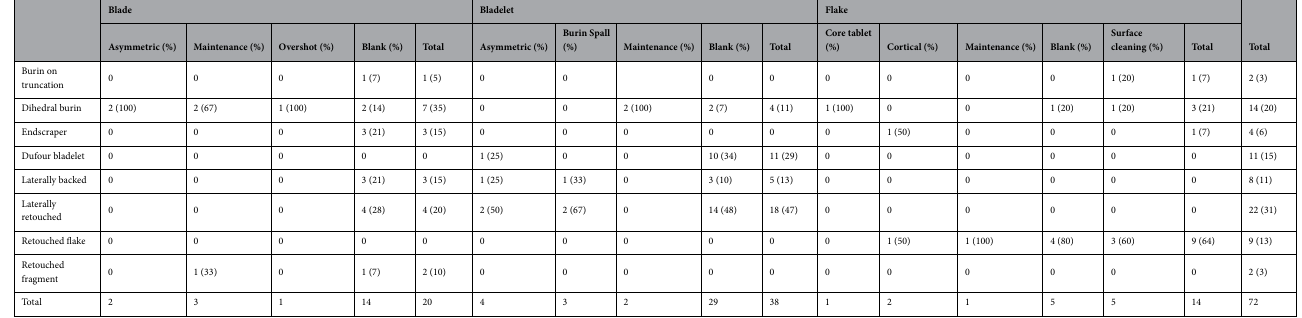
Blade Bladelet Flake TotalAsymmetric (%) Maintenance (%) Overshot